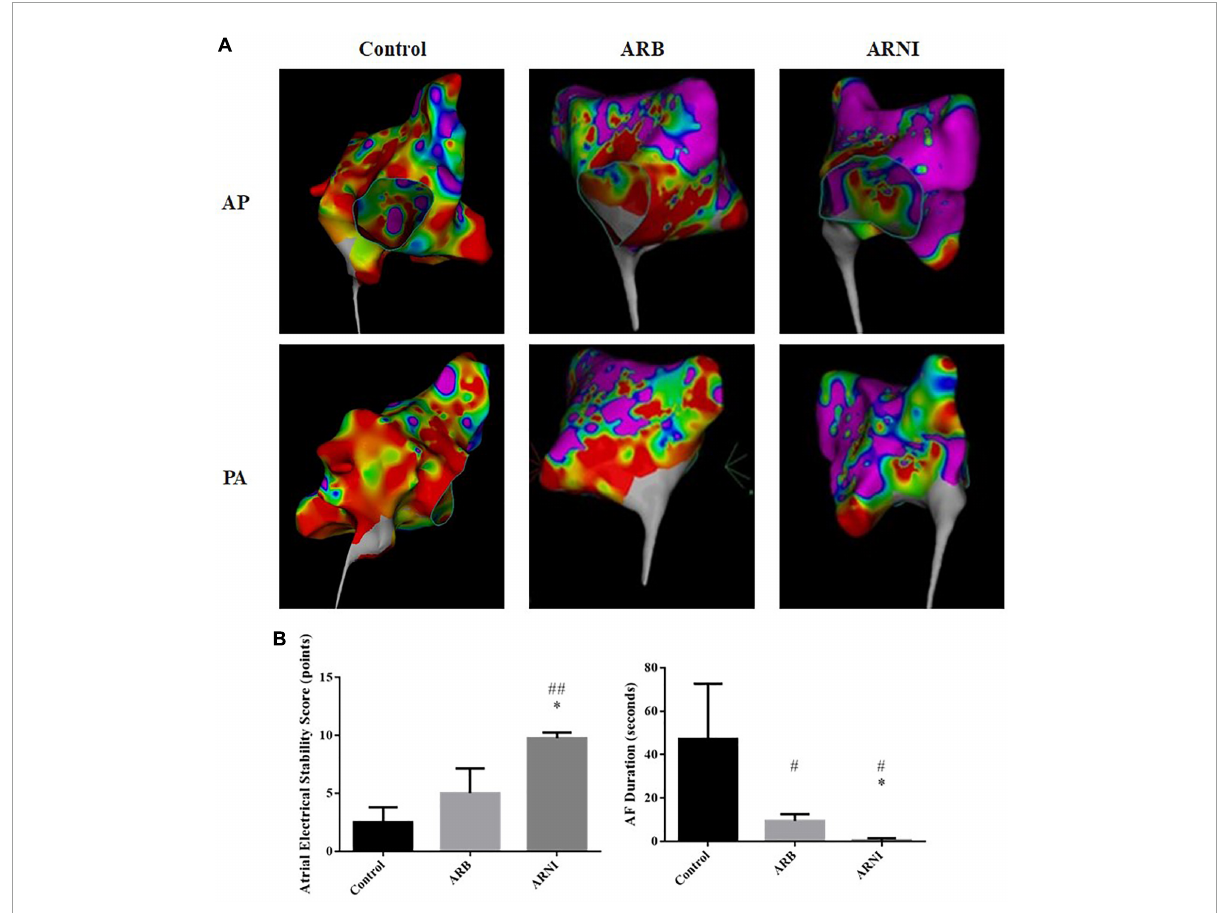
FIGURE3 Electrophysiological study data. (A) LA voltage mapping in sinus rhythm in chest PA and AP views. Red area represents a low LA voltage zone with bipolar peak-to-peak electrogram voltage < 0.50 mv. Purple area represents bipolar peak-to-peak electrogram voltage > 3.0 mv. ARNI group had less low voltage and disordered voltage zone in left atrium. (B) Data after electrical stimuli. ARNI group had a higher atrial electrical stability score and a shorter AF duration. # P < 0.05 compared to Control group; ## P < 0.01 compared to the Control group; ∗ P < 0.01 compared to ARB group. AF, atrial fibrillation; LA, left atrium; AP, anteroposterior; PA,